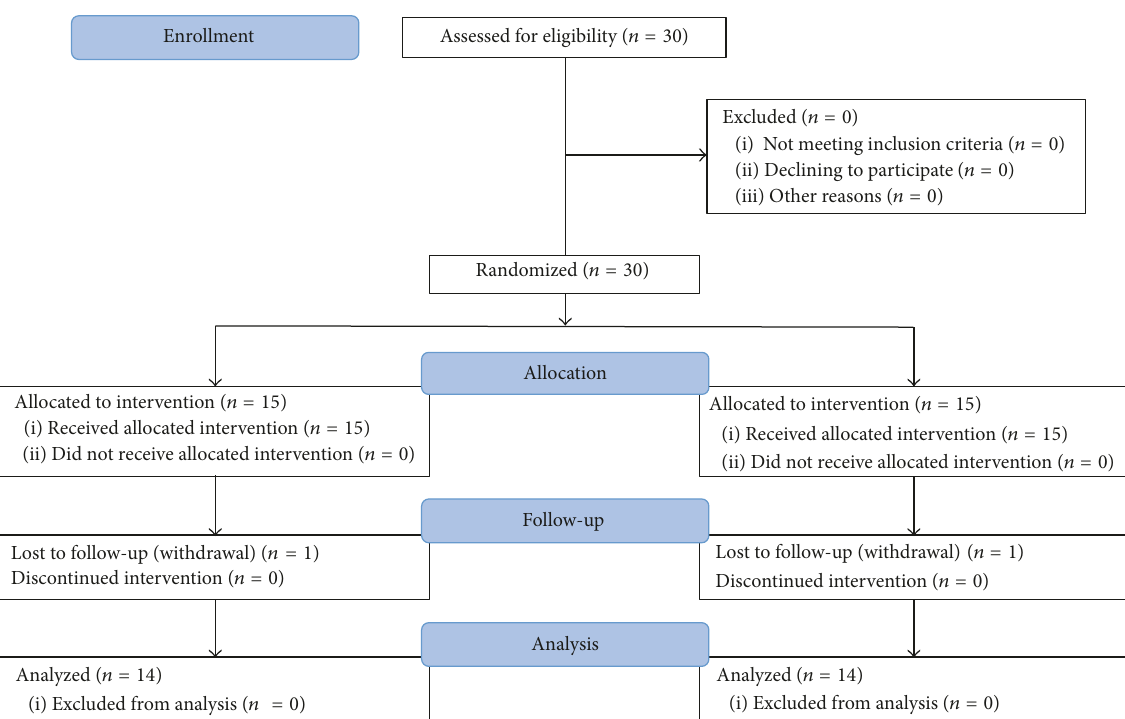
Figure 1: CONSORT flow